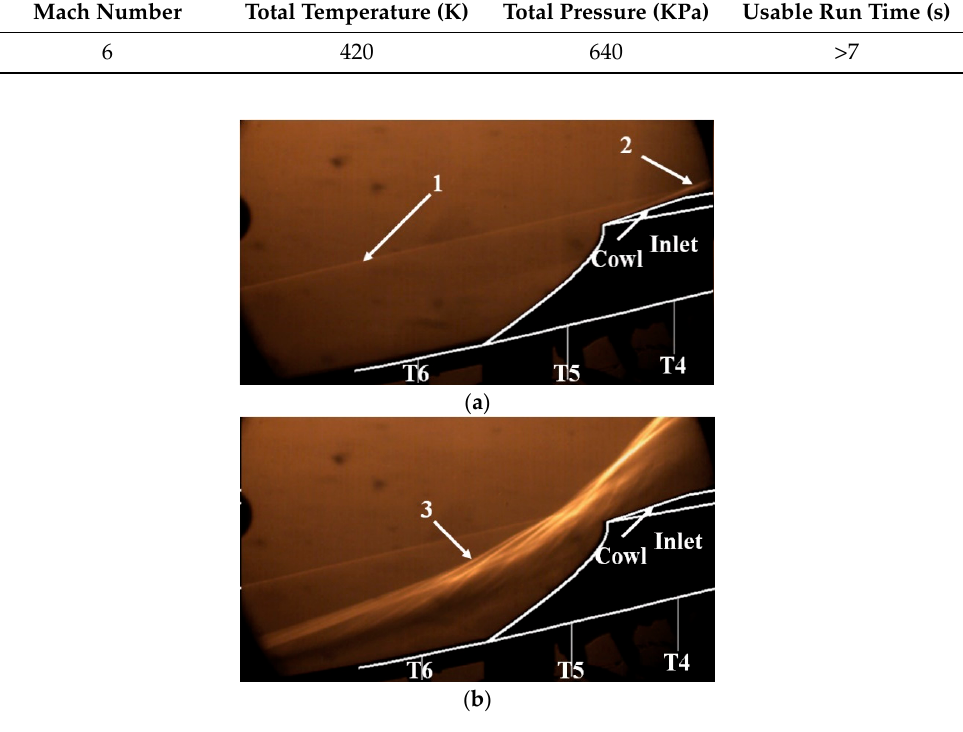
Figure 6. Schlieren images of the started and unstarted flow (( a ) started state; ( b ) unstarted state).